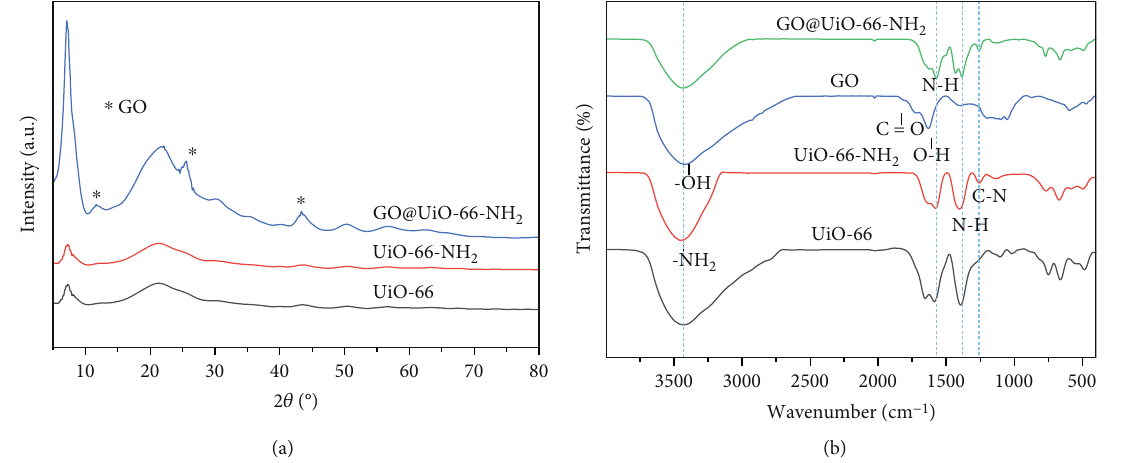
Figure 1: (a) XRD pattern of the prepared materials; (b) FTIR spectra of the prepared